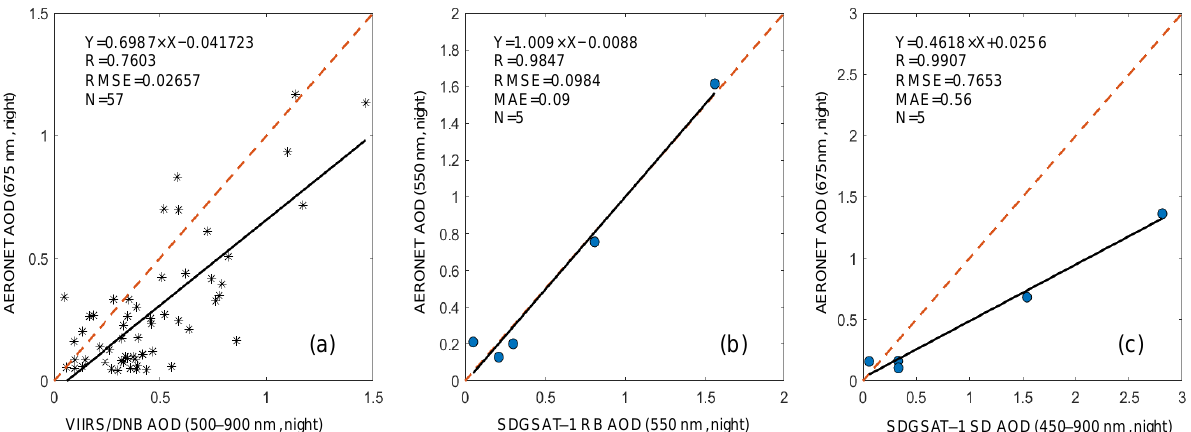
Figure 7. The comparison between AOD values from SDGSAT-1/GLI and AERONET site. ( a ) is the correlation analysis of AOD from nighttime stations and VIIRS/DNB images, ( b ) is the linear regression of AOD from nighttime stations and SDGSAT-1/GLI images based on RB algorithm, and ( c ) is the linear regression of AOD from nighttime stations and SDGSAT-1/GLI images based on SD algorithm.